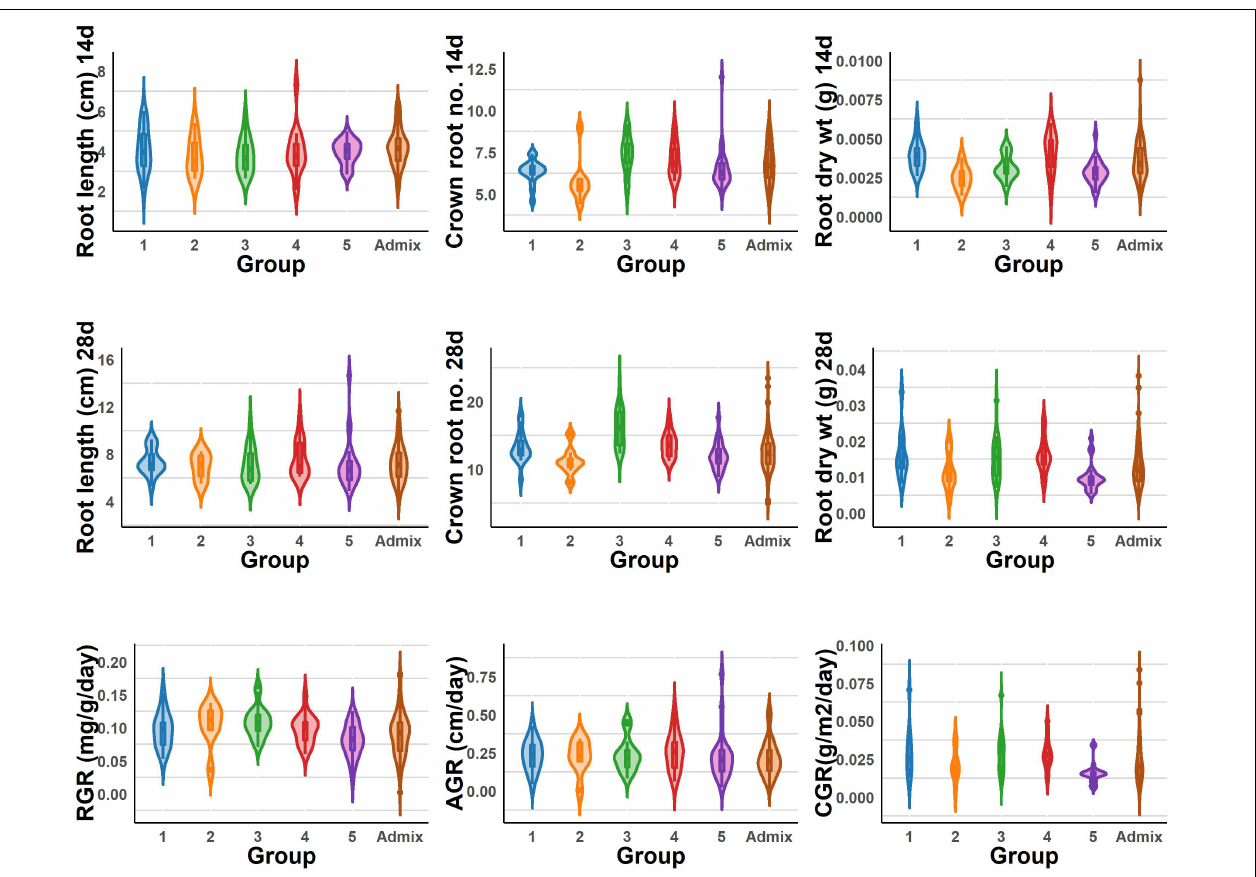
FIGURE 5 | Violin graph represents the range root length, dry weight, crown root number of 14 and 28 days, and root vigor index variations under DSR conditions of different BAAP groups in the wet